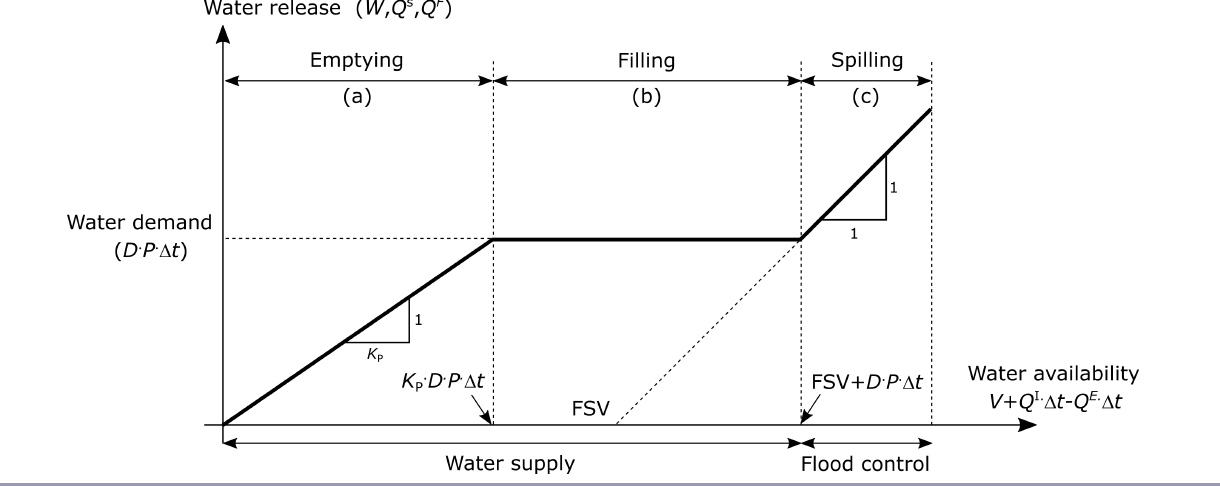
Fig. 4 . Operational policy used in this study, where FSV is full supply volume, D is the per-capita water demand, P is the population, V is the reservoir volume, Q I is the inflow to the reservoir, W is the water withdrawal, Q S is the monthly spillway released, Q F is the spillway released during flooding, Q E is the environmental flow, and K P is the slope of the hedging release function (adapted from Shih and ReVelle